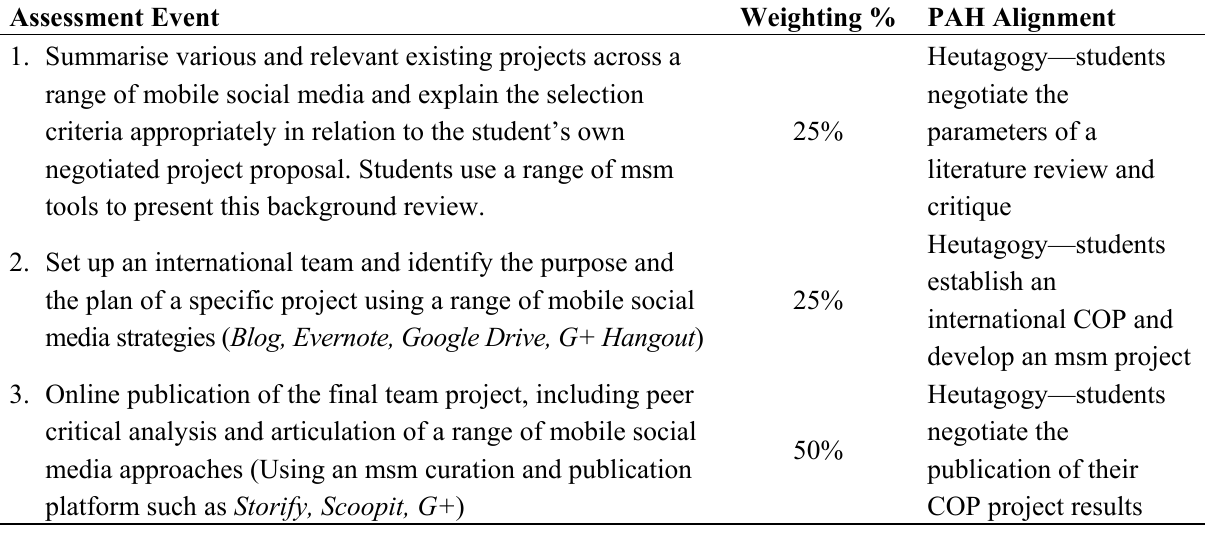
Table 8. International community of practice assessment